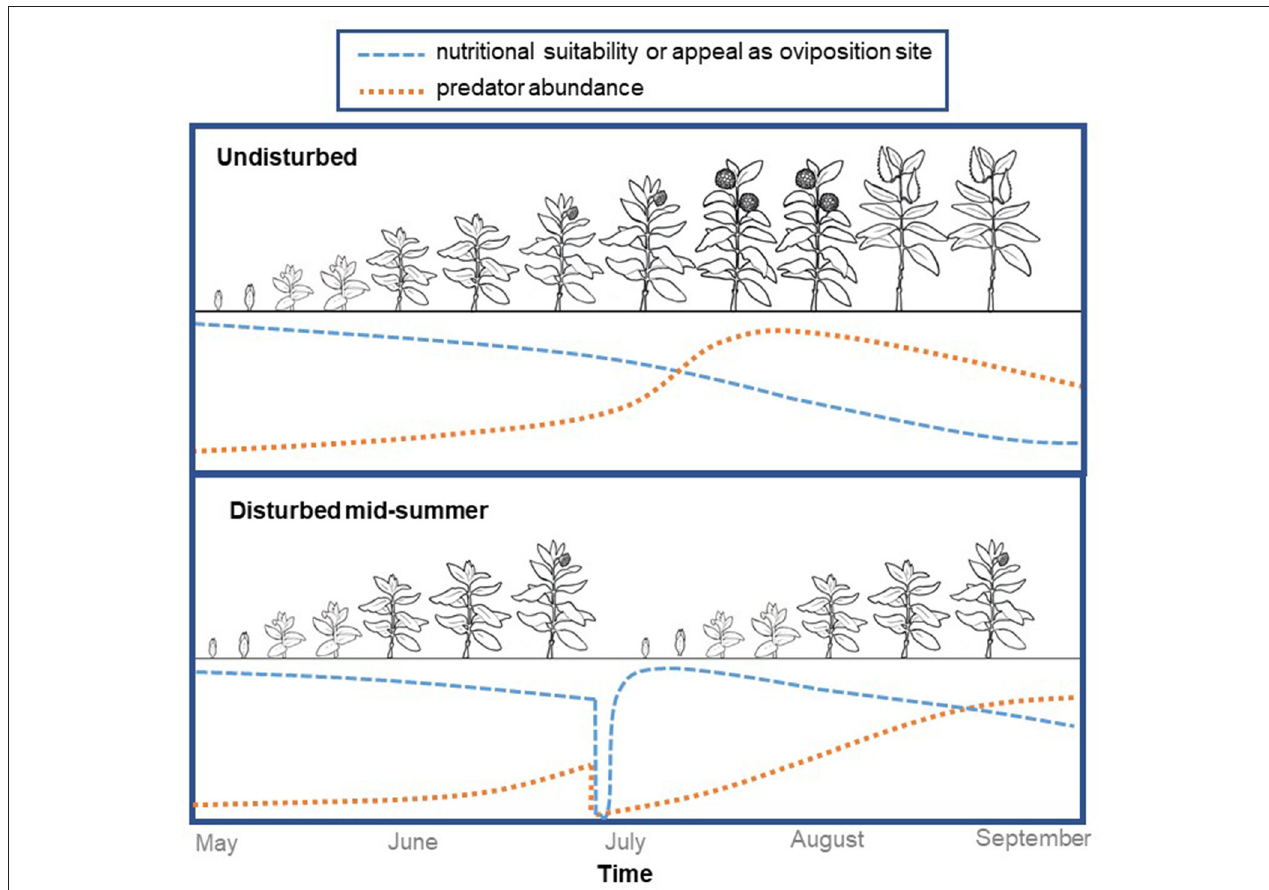
FIGURE 1 | Disturbance resets milkweed phenology, providing new stems in the vegetative stage for monarch oviposition while also reducing predator abundance. Here we show idealized curves representing changes in milkweed’s oviposition appeal and/or nutritional quality (blue) and in arthropod predator abundance (orange). In the plot representing undisturbed milkweeds (top) we show predator abundance peaking during the flowering stage because in recent work we found that predators were particularly dense on flowering